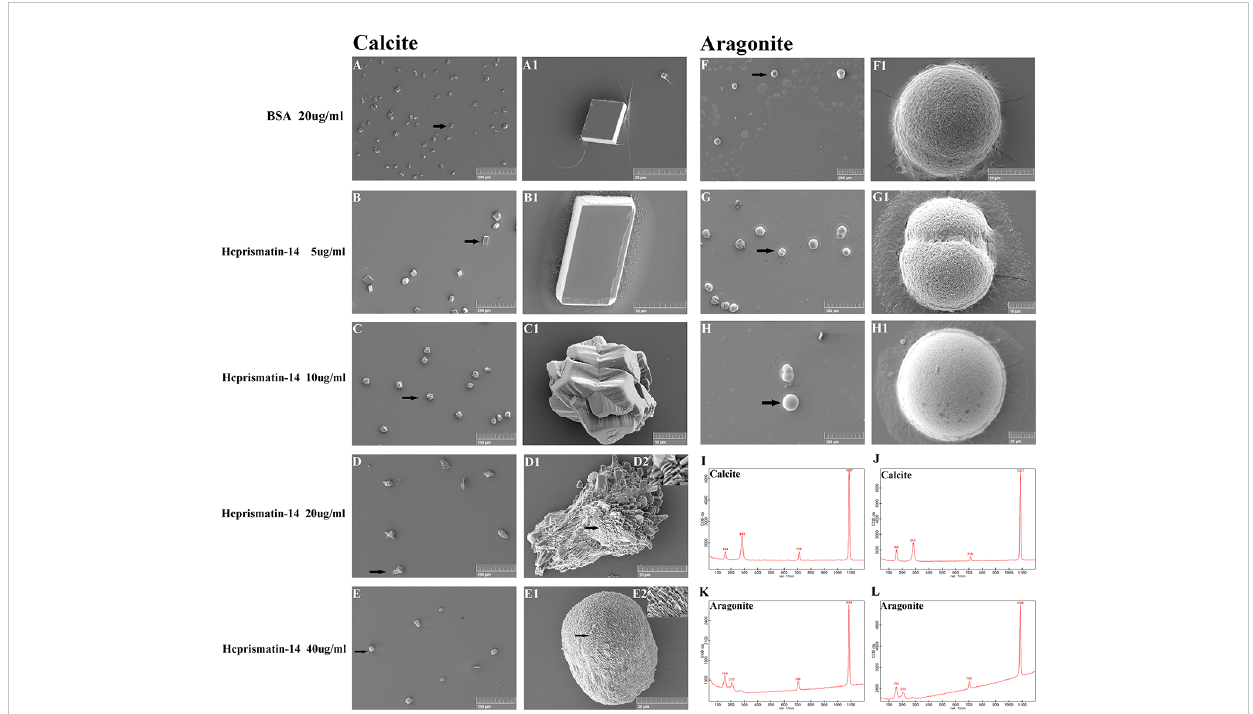
FIGURE 6 Scanning electron microscopy (SEM) observation and Raman spectra detection of in vitro crystallization assay in the present of WDD-repeat region polypeptide. (A – E) SEM observation of the calcite system. Crystallization with: (A, B) 20 m g/mL BSA as a negative control and 5 m g/mL WDD-repeat region polypeptide; crystals were typical rhombohedra with a smooth surface; (C) 10 m g/mL WDD-repeat region polypeptide, crystals were irregular shape; (D) 20 m g/mL WDD-repeat region polypeptide, the crystals were cylinder-shaped; and (E) 40 m g/mL WDD-repeat region polypeptide, the crystals were spherical-shaped. (A1 – E2) Enlargement of the arrows shown in A – E: (A1-B1) the surface of rhombohedra was smooth; (C1) the crystals were consisted of several cylinder-like crystals; (D1-D2) the cylinder-shaped crystals were consisted of sparse scaly plates; (E1-E2) the spherical- shaped crystals were consisted of denser and fi ner scaly plates. (F – H) SEM observation of the aragonite system. Crystallization with 20 m g/mL BSA in (F) , 5 m g/mL WDD-repeat region polypeptide in (G) , 10 m g/mL WDD-repeat region polypeptide in (H) . (F1 – H1) Enlargement of the arrows shown in F – H. The number of hemispherical crystals decreased gradually as the concentration of polypeptide increased; (I, J) Raman spectra of the crystals formed in calcite systems. (K, L) Raman spectra of the crystals formed in aragonite